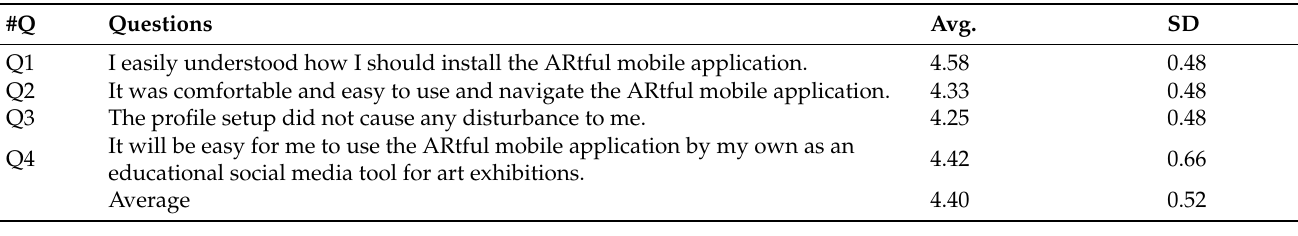
Table 4. Questions and average ratings of participants’ attitude concerning the setup of the ARtful mobile app.